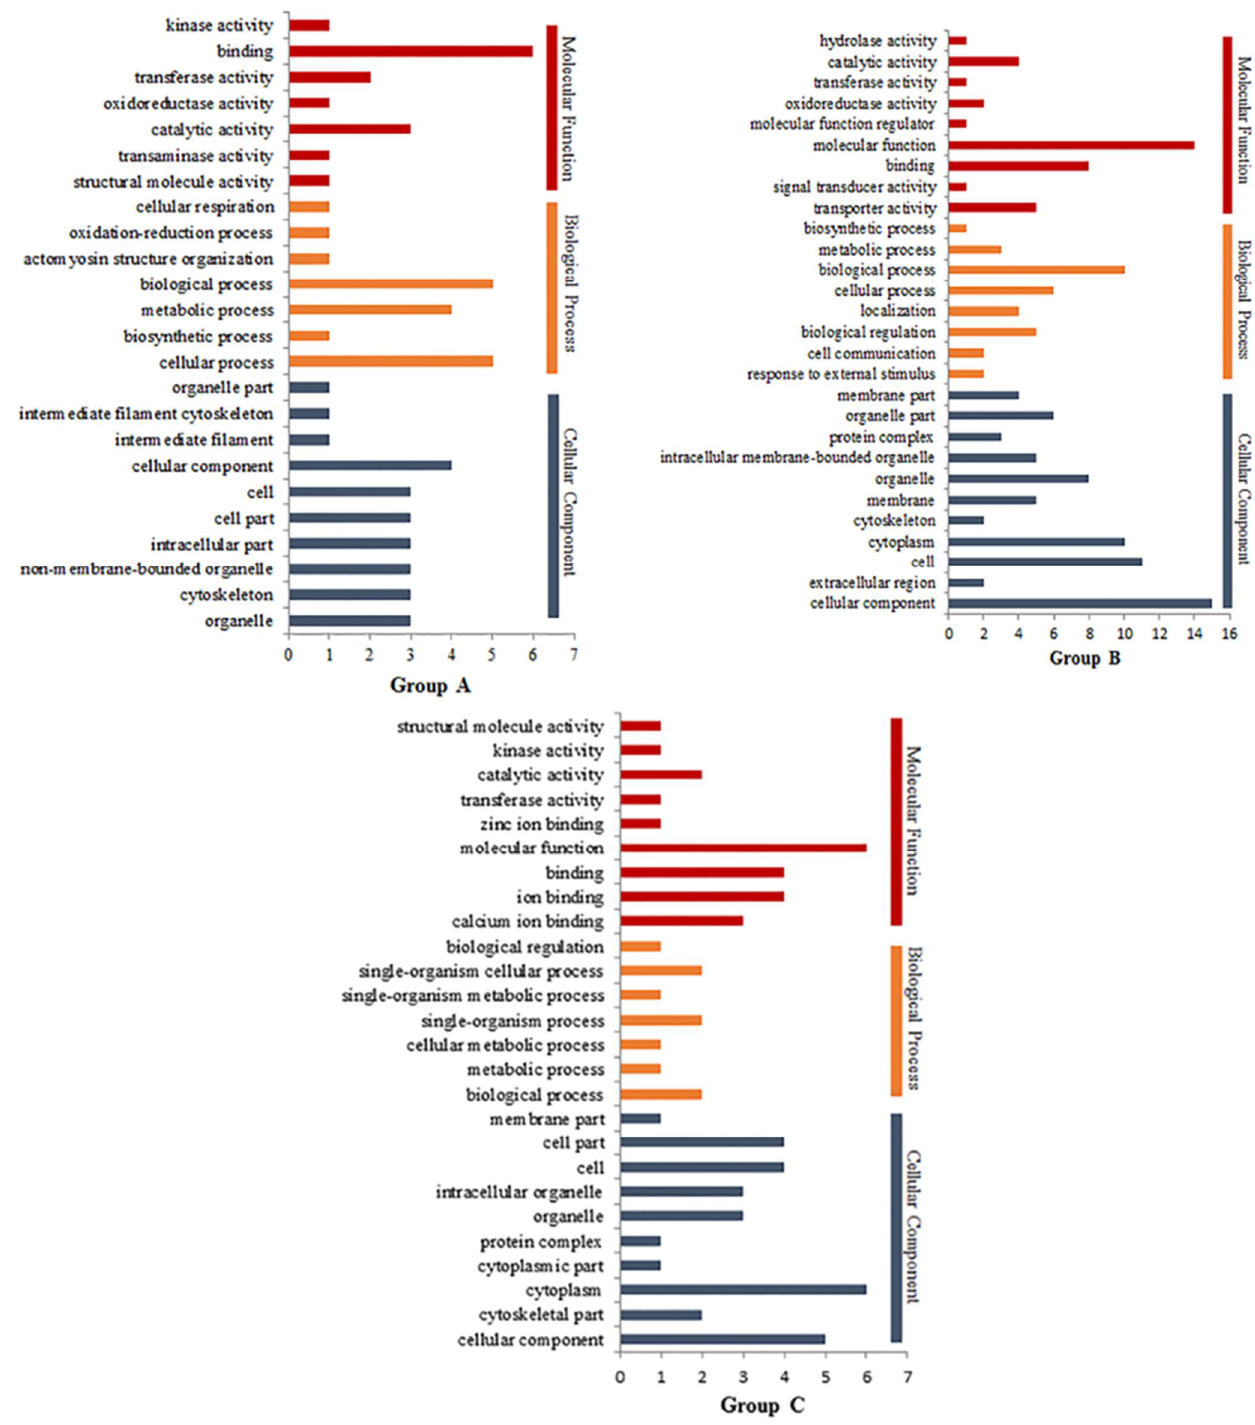
Figure 5. GO analyses of three groups. The figure only shows the cellular components, biological processes and molecular functions of the three groups ( A – C ).